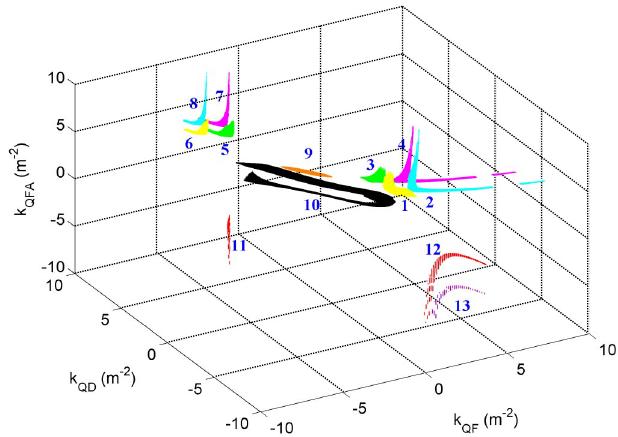
FIG. 6. (Color) The color mapping scheme in Fig. 5 is mapped into k -space for one of the 12 ALS TBA